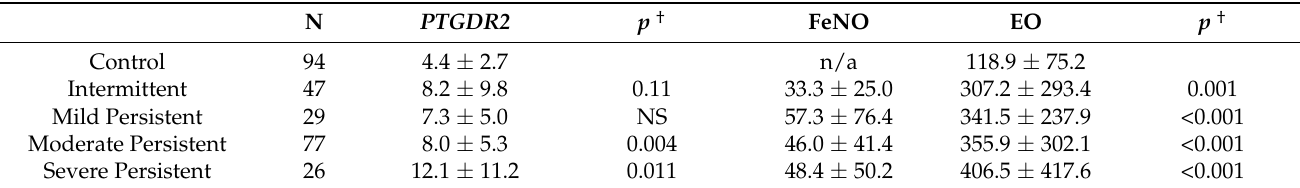
Table 6. Peripheral blood eosinophil, FeNO, and PTGDR2 expression levels according to asthma